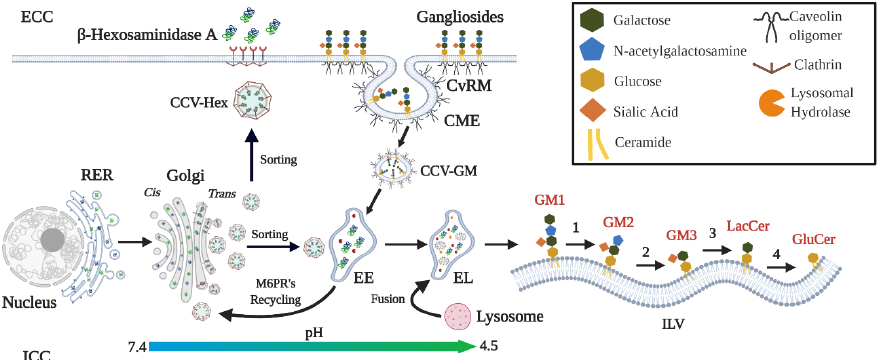
Figure 1. M6PR-dependent transport of β -Hexosaminidase A and ganglioside degradation. α and β subunits of Hex are synthesized in the rough endoplasmic reticulum (RER) and transported to the Cis- Golgi network. In this compartment, Hex is subject to N-glycosylations and phosphorylations